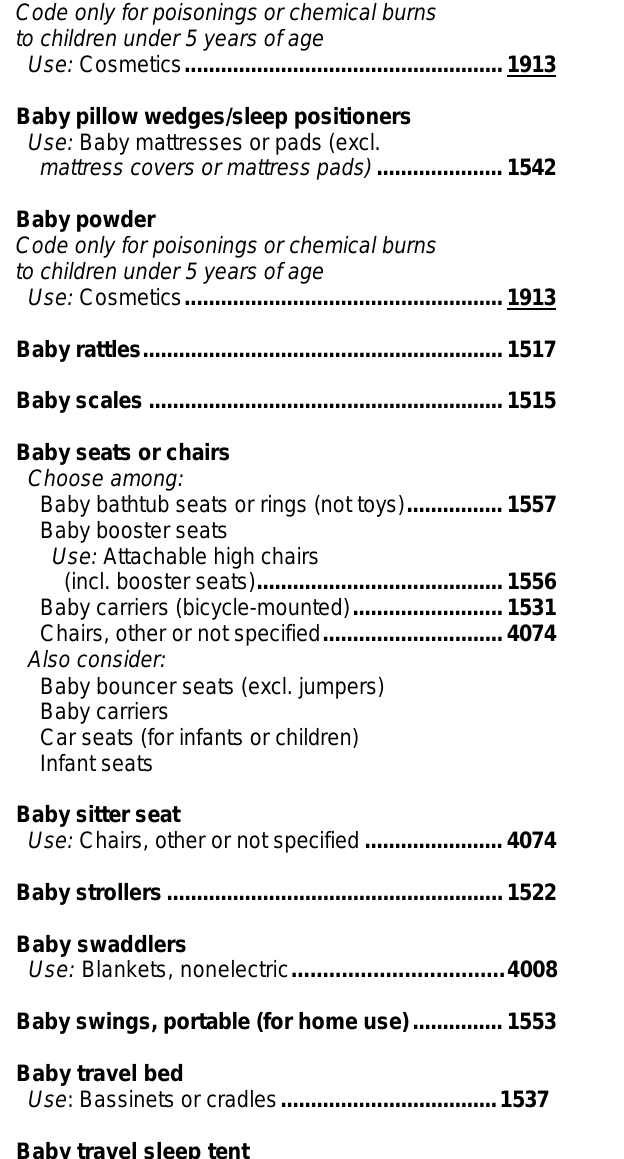
Also consider: Baby bouncer seats (excl. jumpers) Baby carriers Car seats (for infants or children) Infant